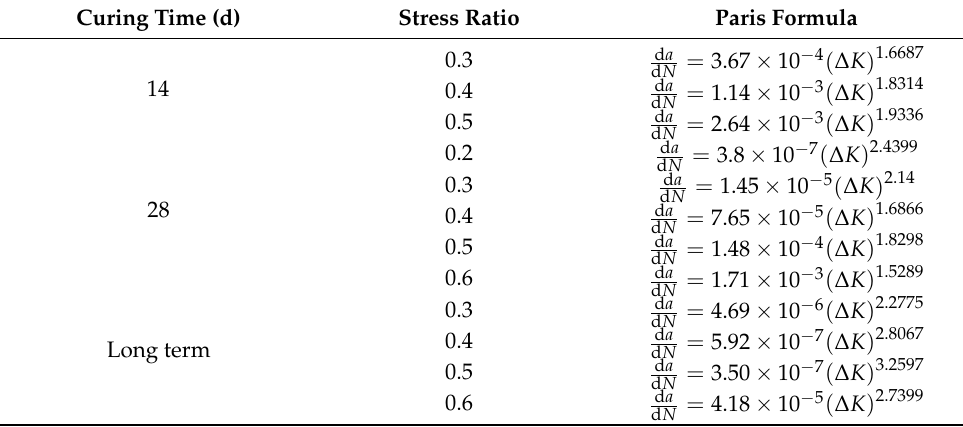
Table 9. The fitting results of the Paris formula. Curing Time